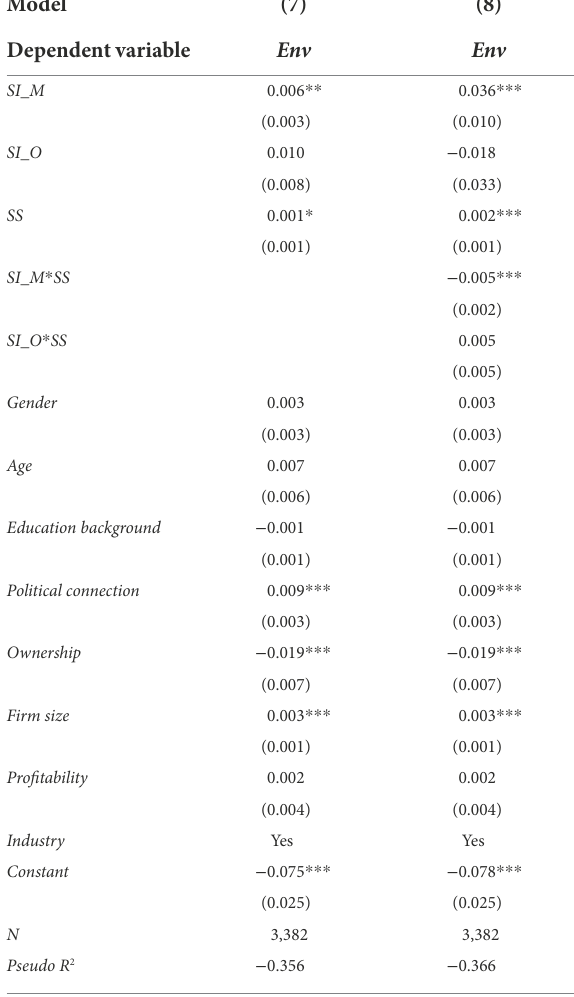
TABLE 5 Comparison between management succession intention and ownership succession intention.